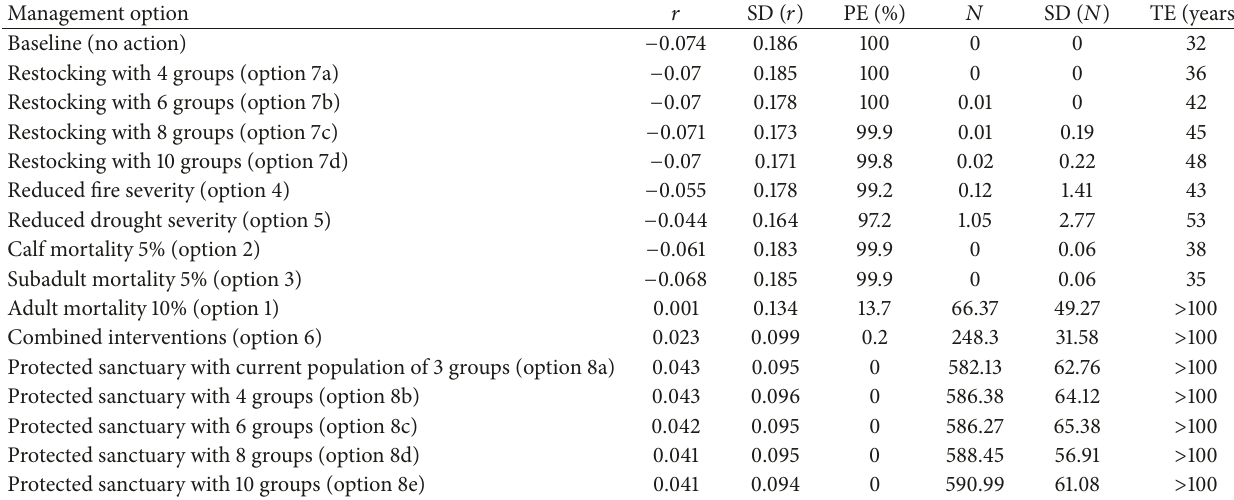
Table 3: Results of the VORTEX PVA model for roan antelopes simulated over 100 years under alternative management options. Management option